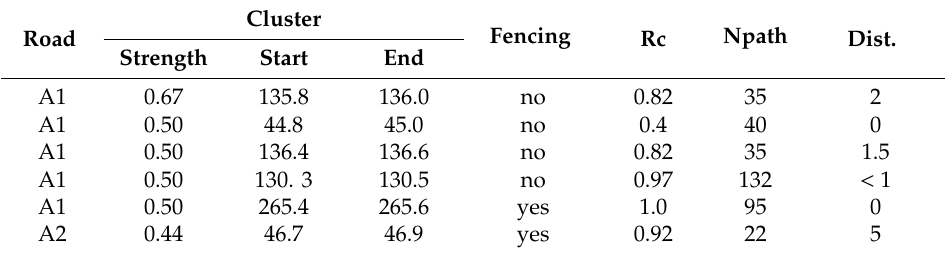
Table 3. Evaluation of the prognostic possibilities of the moose movement model for highways A1 and A2, comparing with the MVC cumulative data for 2015–2017: Bandwidth 150 m, Rc—cumulative segment rank. Npath—number of pathways crossing the segment. Dist.—distance (km) between cluster and nearest Rc/Npath value.